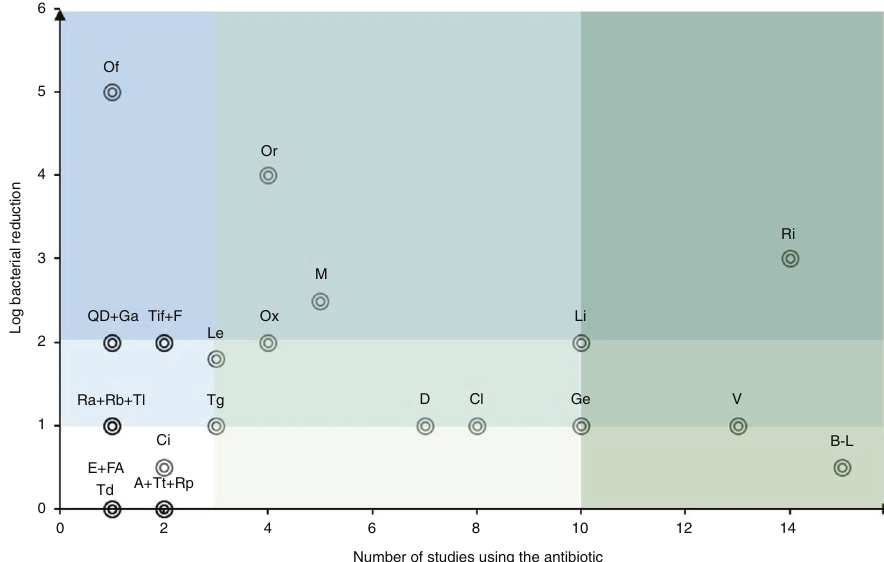
Fig. 3 A representation of the effectiveness of antibiotics against intracellular S. aureus and the number of studies that tested the antibiotic. A typical log-reduction value for each antibiotic formulation, which was either reported or gauged from data included in the study in question, was assigned (y-axis) and plotted against the number of studies contributing to these values (x-axis). Supporting data for this analysis are detailed in Tables 1 – 3. Dark blue zone = high effectiveness, light blue zone = medium effectiveness, white zone = low effectiveness. Dark green zone = highest number of studies, light green zone = low number of studies, white zone = individual studies. A = azithromycin, B- L = beta-lactam antibiotics (except oxacillin), Ci = cipro fl oxacin, Cl = clindamycin, D = daptomycin, E = erythromycin, F = fosfomycin, FA = fusidic acid, Ga = garenoxacin, Ge = gentamicin, Le = levo fl oxacin, Li = linezolid, M = moxi fl oxacin, Of = o fl oxacin, Or = oritavancin, Ox = oxacillin, QD = quinupristin/dalfopristin, Ra = radezolid, Rb = rifabutin, Ri = rifampicin, Rp = rifapentin, Td = tedizolid, Tg = tigecycline, Ti = teicoplanin, Tl = telavancin, Tt = telithromycin, V =